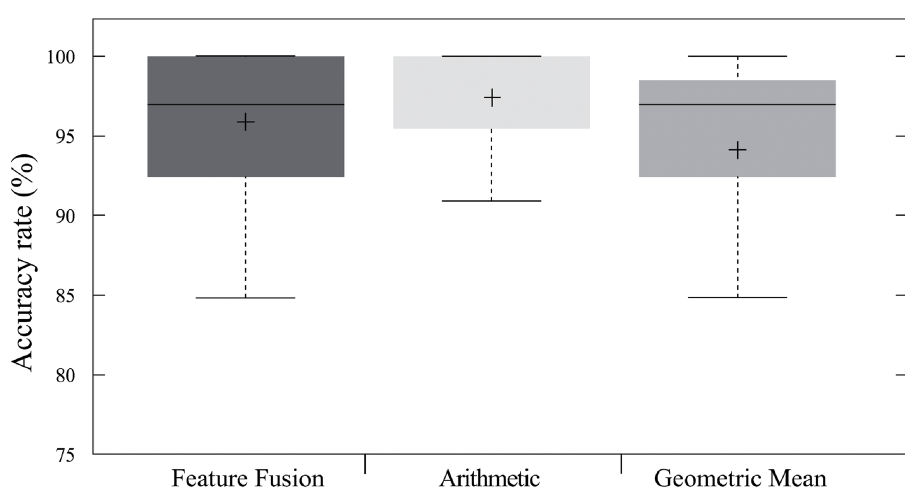
Fig 6. Average accuracy rate of the proposed model using LSTMRes with feature-fusion and score-fusion techniques. Accuracy of shared-weights LSTMRes with feature fusion (95.71%), and score fusion employing the arithmetic mean (97.22%) and geometric mean (93.93%).